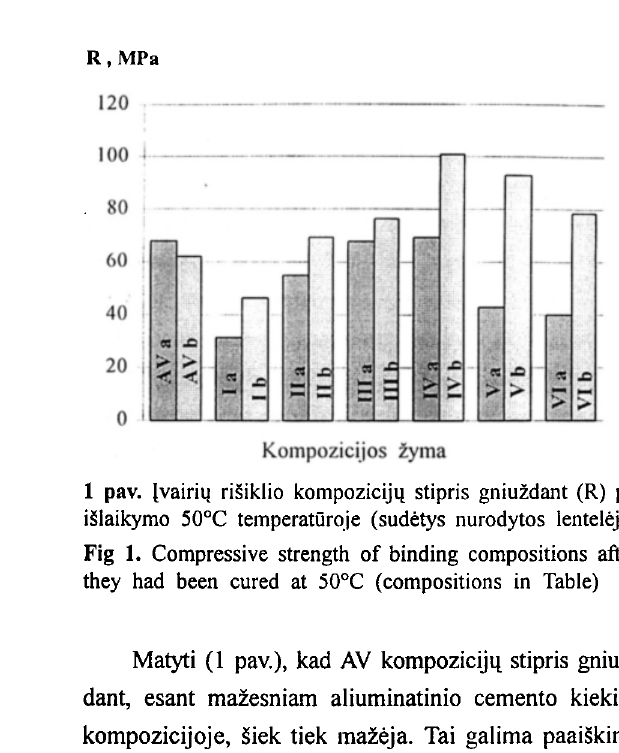
Fig 1. Compressive strength of binding compositions after they had been cured at 50°C (compositions in Table) Matyti (1 pav.), kad AV kompozicijq stipris gniuz dant, esant mazesniam aliuminatinio cementa kiekiui kompozicijoje, siek tiek mazeja. Tai galima paaiskinti tuo, kad ferochromo slakas vandeniu uzmaisytoje te sloje yra inertine medziaga.